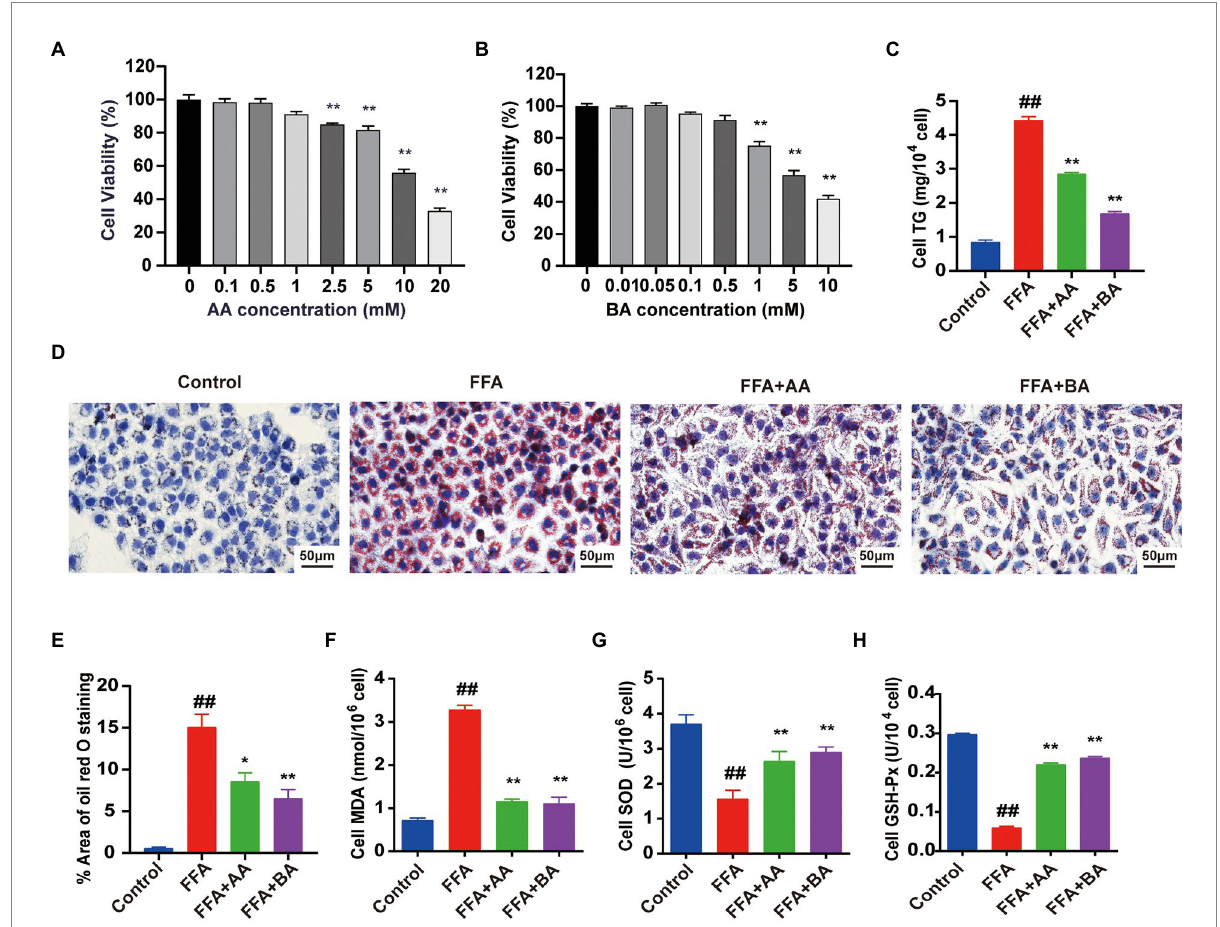
FIGURE 8 Effects of acetic acid and butyric acid on cell viability and FFA-induced lipid accumulation and oxidative stress in L02 cells. (A,B) The effects of AA and BA on L02 cell viability performed by CCK8 assays. (C) Cell TG level. (D) Cell Oil red O staining (magnification, ×400). (E) Quantitative analysis of oil red staining results was performed using Image Pro Plus 6.0 software. (F–H) The level of cell MDA, SOD and GSH-Px, respectively. L02 cells were pre-treated for 24 h with 1.0 mM FFA to constructed NAFLD cell model before treated with 1.0 mM AA or 0.5 mM BA for another 24 h. Data represent means ± SEM. ## p < 0.01 versus Control; * p < 0.05, ** p < 0.01 versus